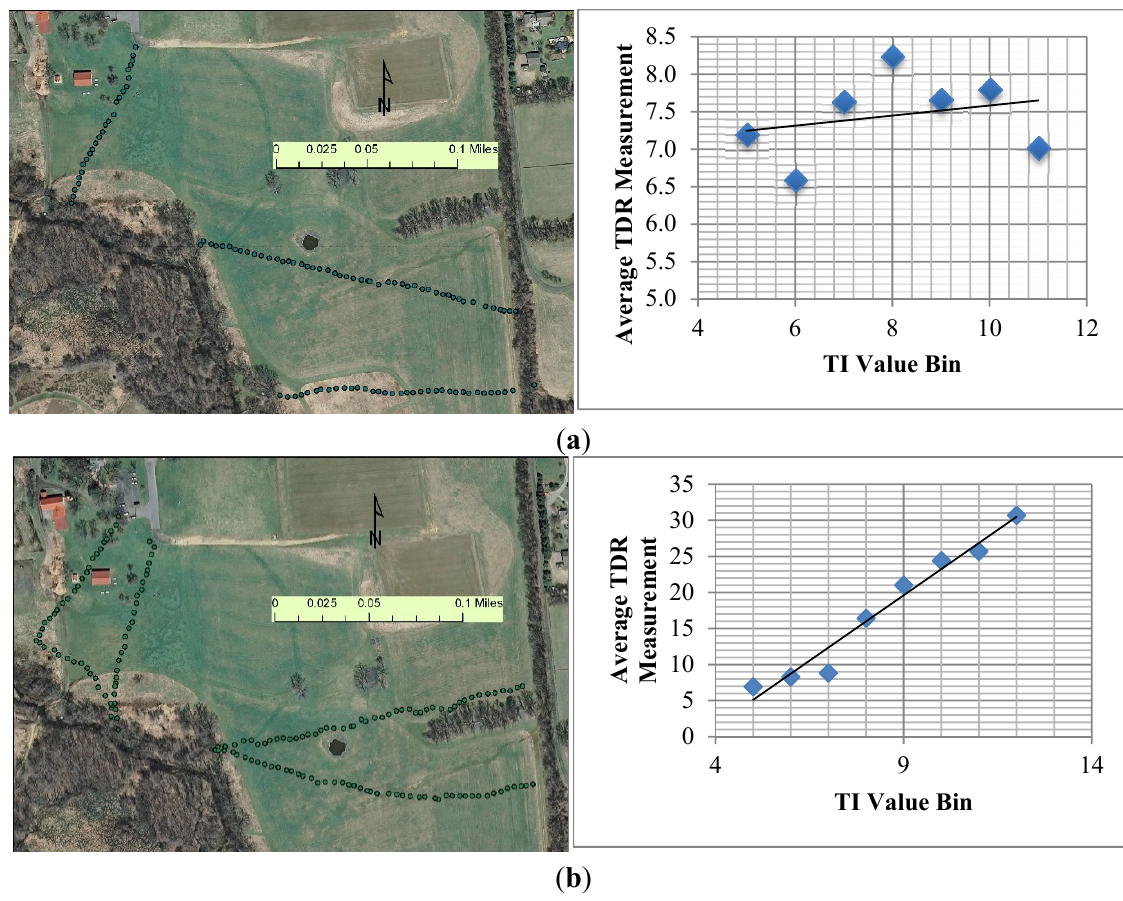
Figure 4. Comparison between TI Values and TDR Measurement (%) at Christy Hoffman Farm Park. ( a ) On 1 December 2009 (TDR = 0.0674TI + 6.9094; R 2 = 0.0703); ( b ) On 17 December 2009 (TDR = 3.6251TI − 13.014; R 2 =